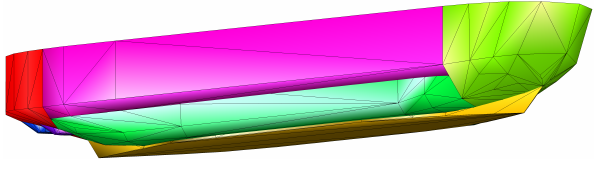
Figure 3: Collision mesh of a conceptual Arctic drill- ship (courtesy Statoil). Different colors rep- resent different convex decomposition